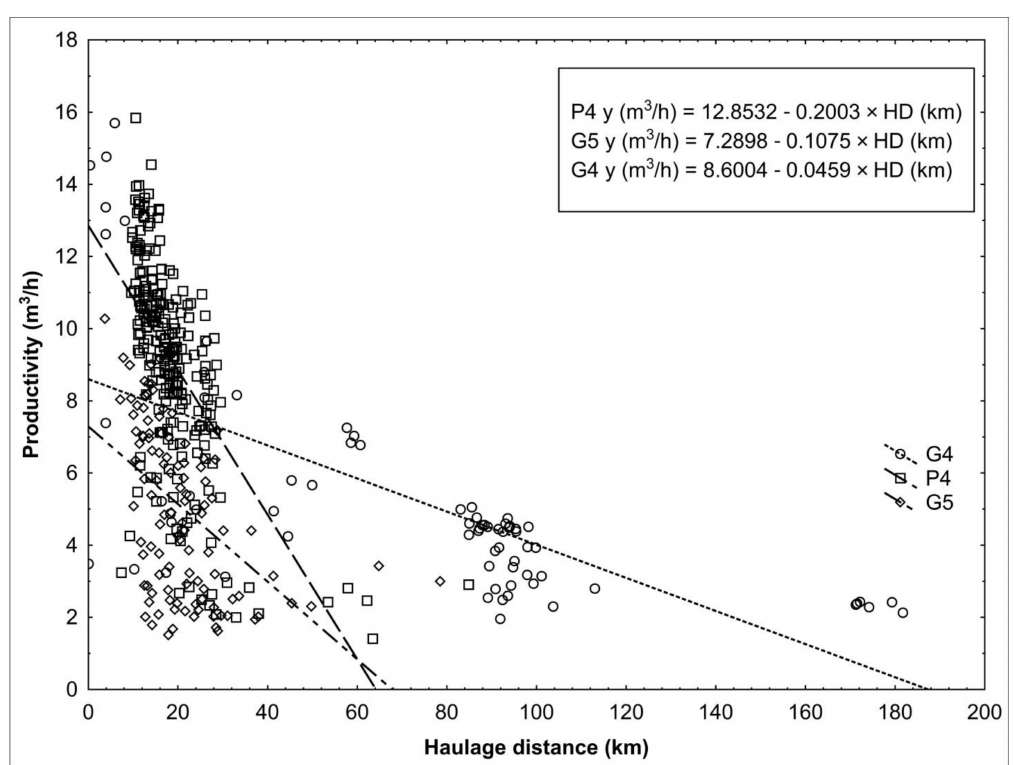
Table 4. Outcomes of the regression and correlation analysis between hourly productivity (y; m 3 h − 1 ) and haulage distance (HD; km).